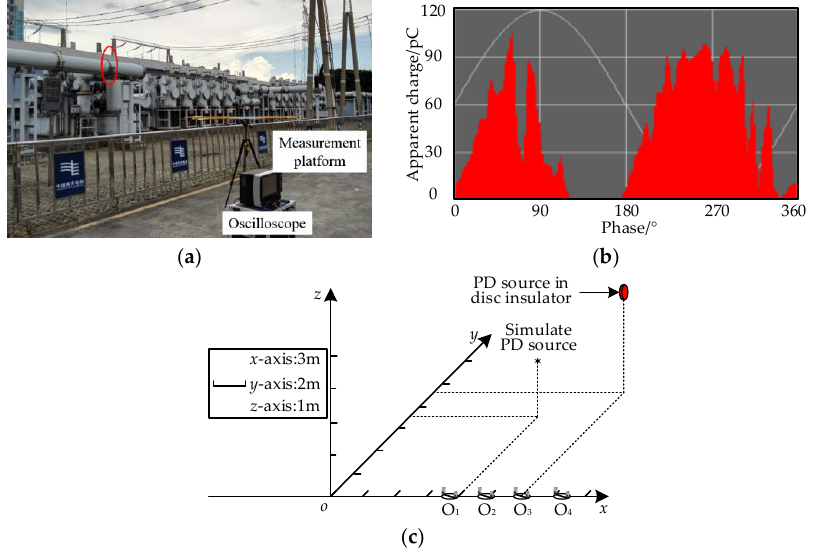
Figure 7. The field test site arrangement and the on-line monitoring result of the disc insulator PD. ( a ) The field test site and the test arrangement; ( b ) The on-line monitoring result; ( c ) The coordinate system of the field test site arrangement.